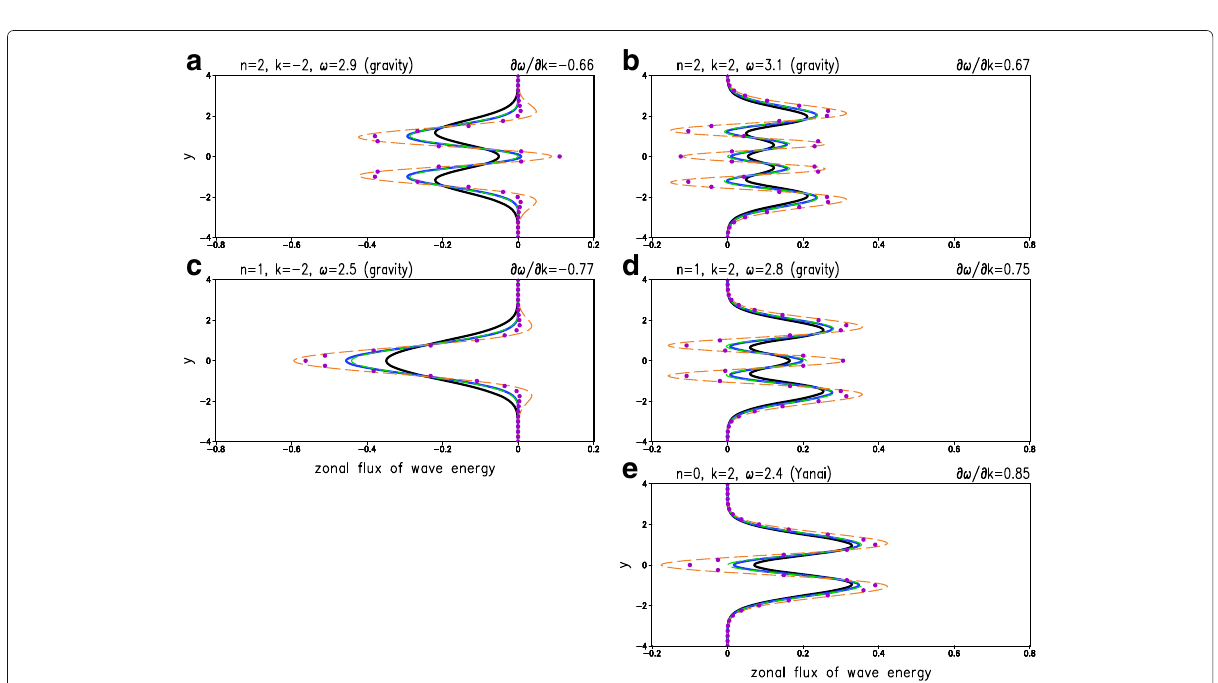
ϕ app ) + ( p ϕ app / 2 ) tt y , the solidblueline is up y , and (cid:15) ∞ ( u 2 + v 2 + p 2 )/ 2 dy = 1 −∞